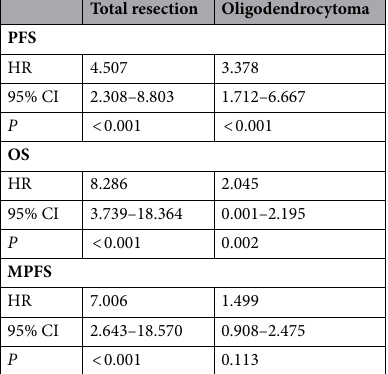
Table 3. Cox regression analysis of factors related to PFS, OS and MPFS in the Whole group. HR hazard ratio, CI confidential interval.